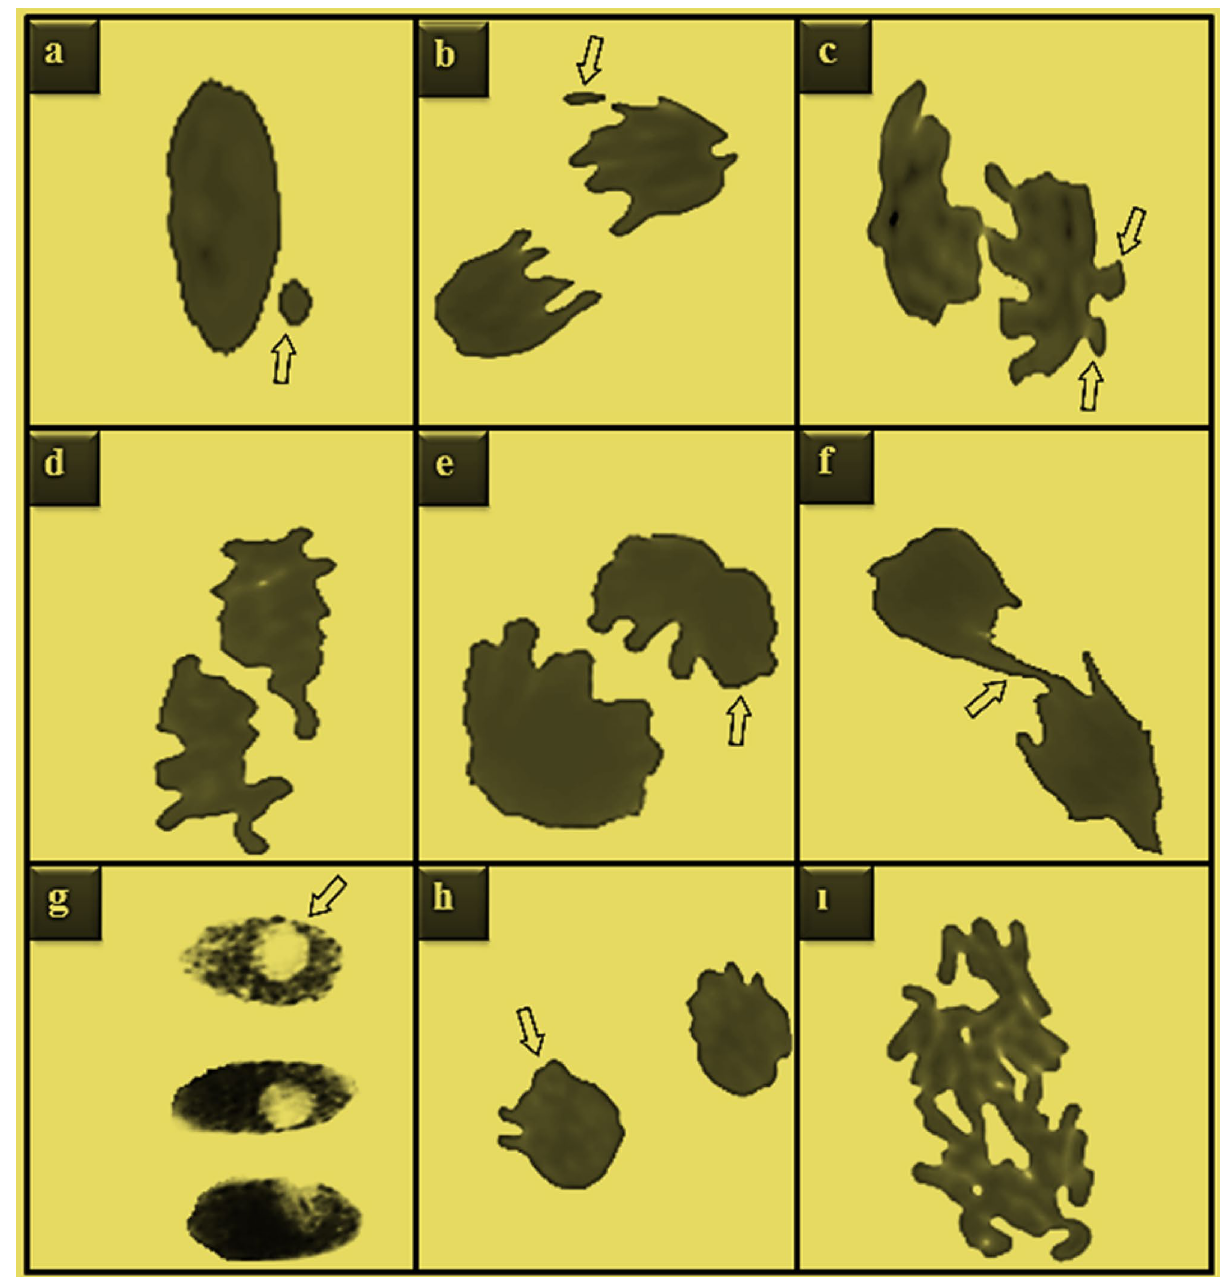
Figure 2. Trifloxystrobin-induced chromosomal damages. MN ( a ), fragment ( b ), vagrant chromosome ( c ), sticky chromosome ( d ), uneven distribution of chromatin ( e ), bridge ( f ), nucleus with vacuoles ( g ), reverse polarization ( h ), irregular mitosis ( i